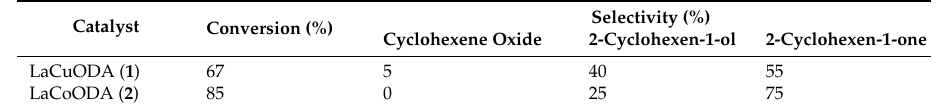
Table 3. Catalytic results after 24 h of the aerobic oxidation of cyclohexene at 75 ◦ C using LaMODA (M = Co II , Cu II ).